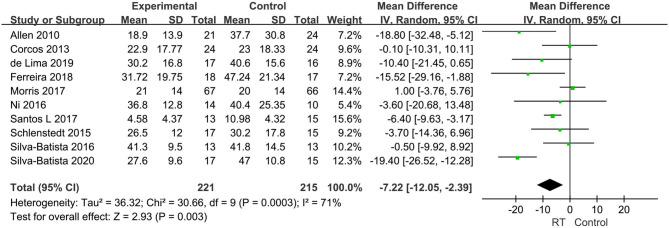
Forest plots of the effects of lower limb RT on quality of life in PD. CI, confidence interval.